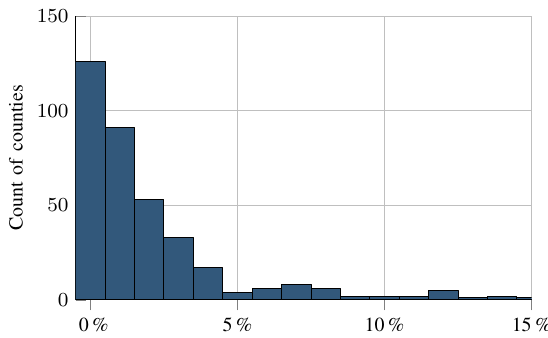
Figure 8. Histogram of the number of counties by the difference between the two approaches. Example how to read: In 33 counties, the difference between the two approaches is